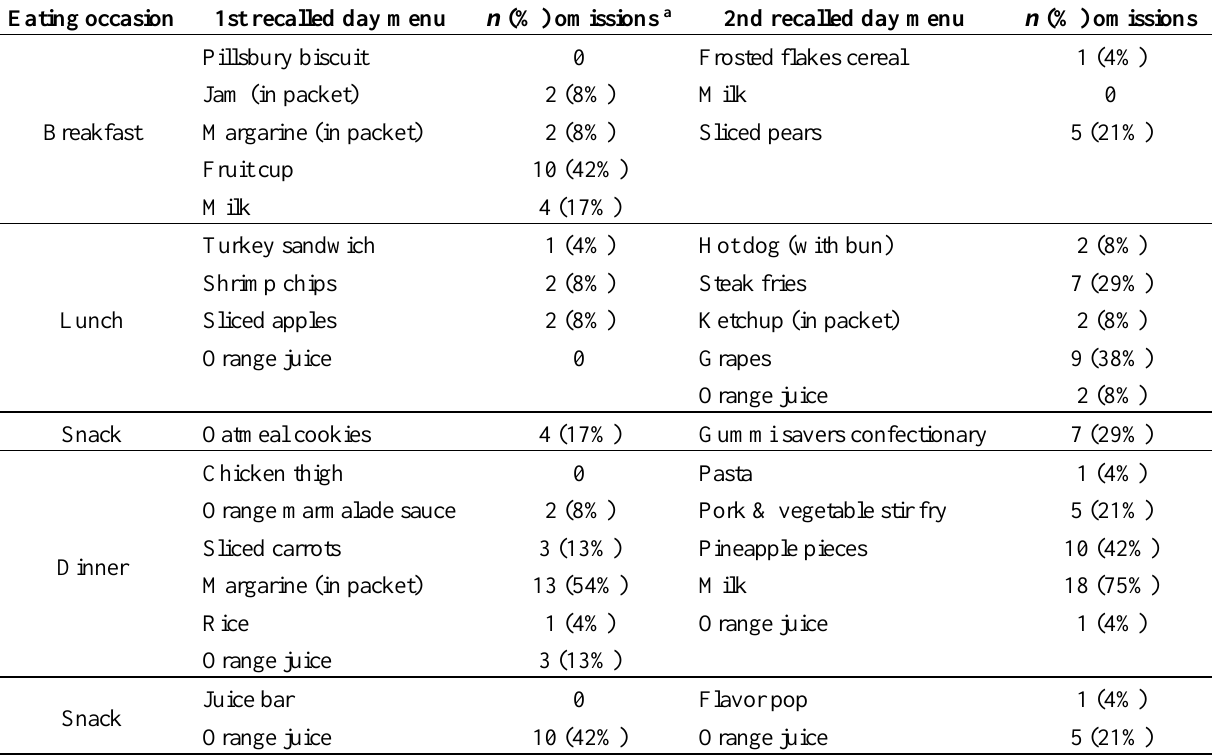
Table 1. Number and percentage of participants ( n = 24) who reported omissions for each menu item in the first and second 24-h dietary